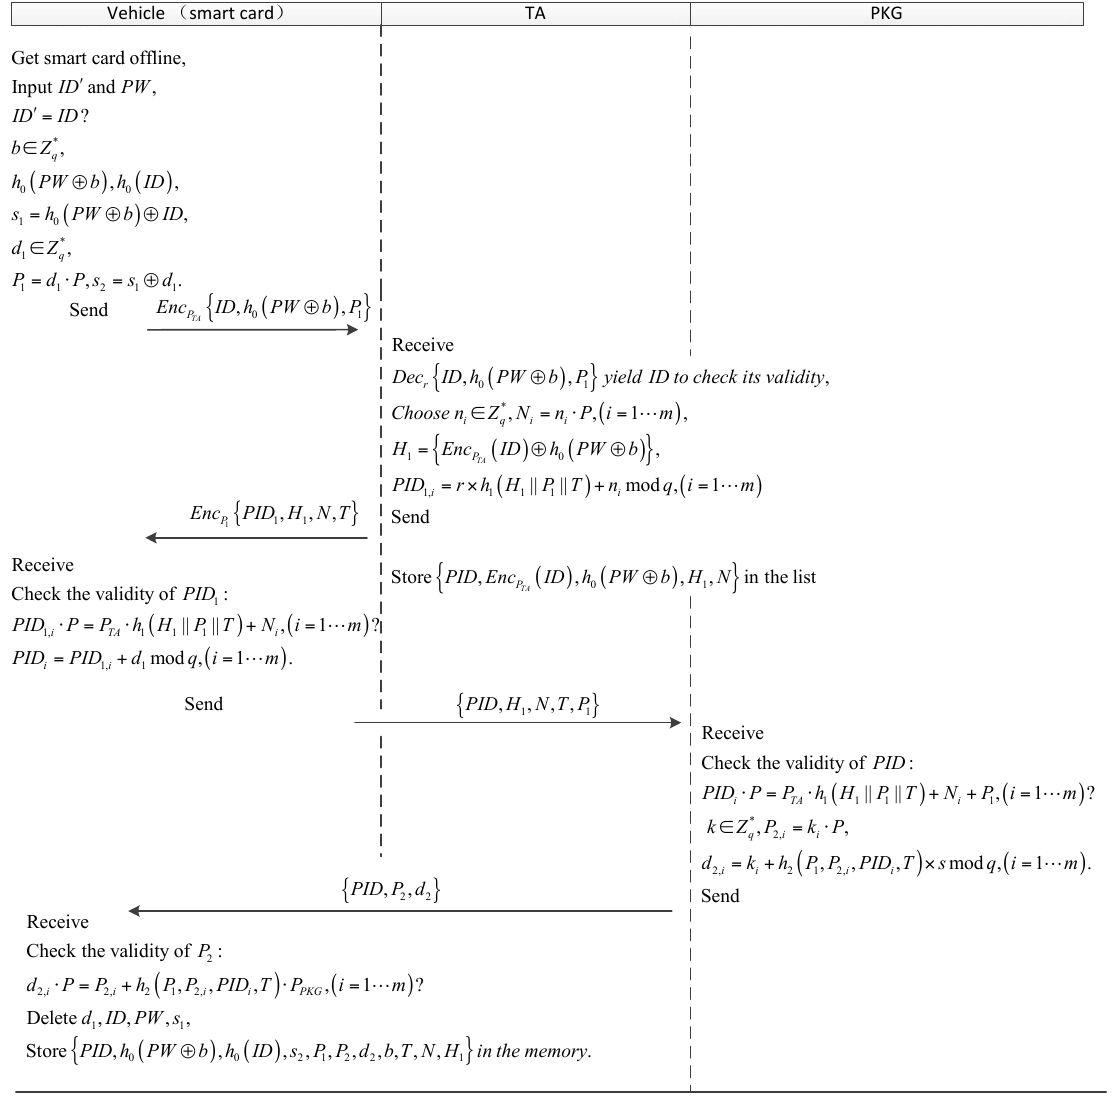
Figure 3. The vehicle to RSU (vehicle) registration process.